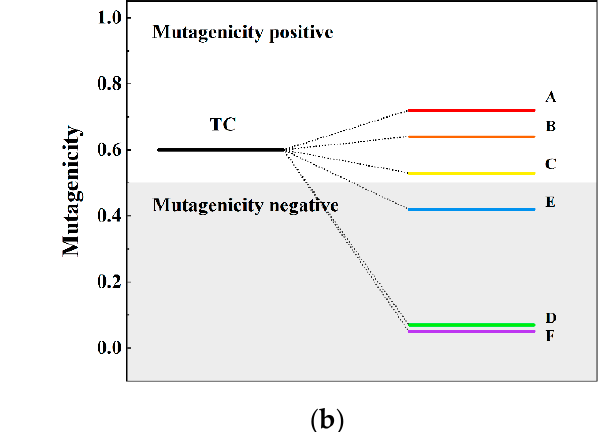
Figure 11. ( a ) Developmental toxicity and ( b ) mutagenicity of TC and the intermediates.